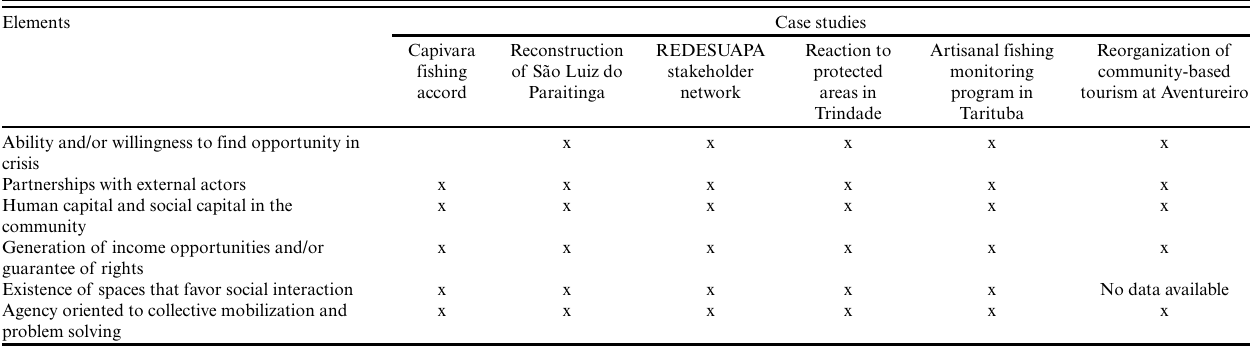
Table 2. Elements present in the case studies of successful community self-organization in Brazil.